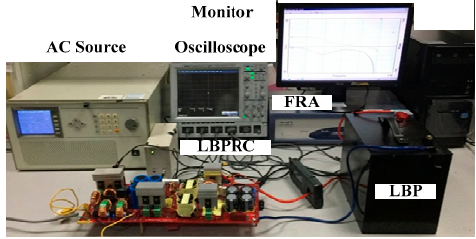
Figure 30. A photo of the practical charge and measurement system.